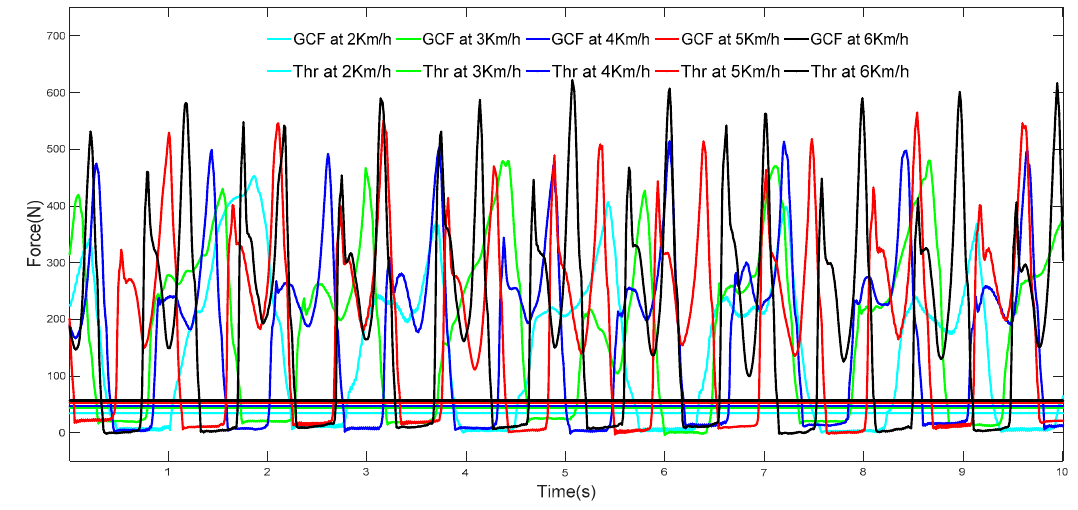
Figure 3. Change in GCFs with walking speed change.